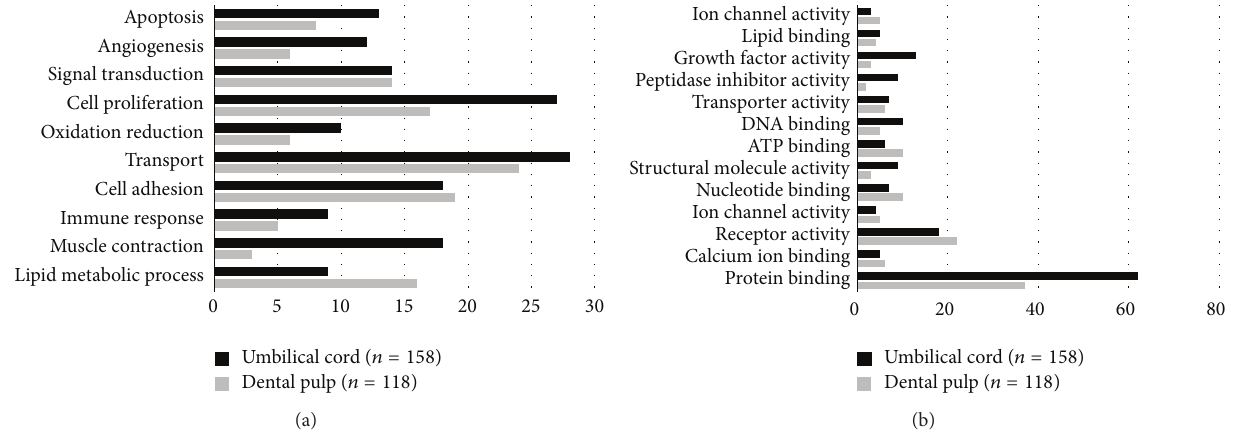
Figure 1: Main categories of genes expressed specifically in umbilical cord and dental pulp classified according to their biological (a) and molecular functions (b). Genes related to cell proliferation and angiogenesis were expressed at higher levels in the UC than in DP ( 𝑝 < 0.05 ).